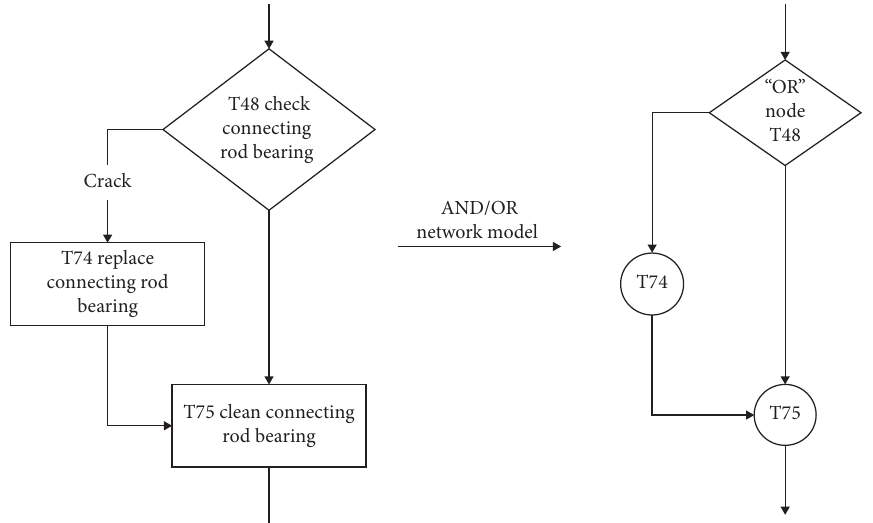
Figure 1: The “OR” node representing an operation of selectable successor operations in D&A operations.